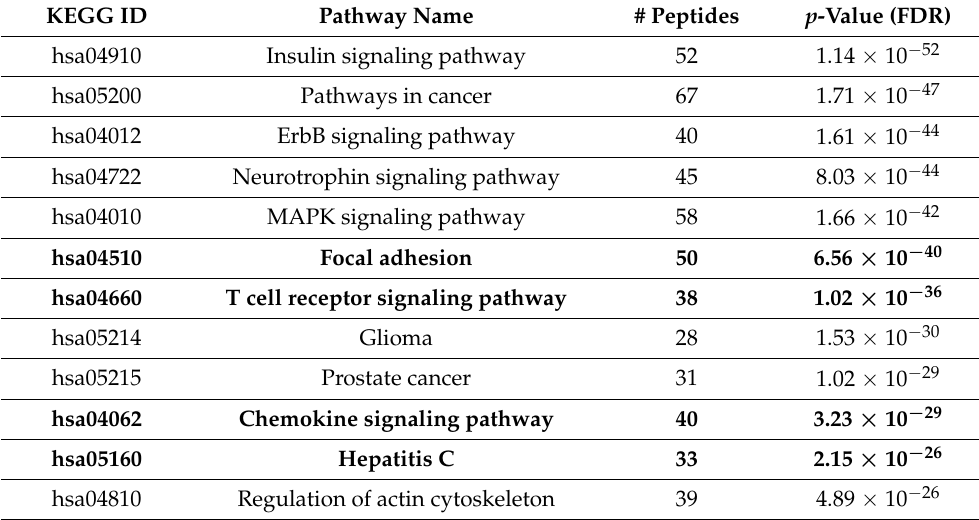
GO analysis where the top three pathways were related to immune function and when combined represent 652 peptides on the array. Table 11. The top 12 KEGG pathways in sub-iliac lymph nodes collected from experimentally and naturally infected cattle. A list of representative pathways is generated using the statistically significant peptides from the comparison and inputting this peptide list into the online STRING database. Presented below are the top 12 pathways. Pathways in bold are those involved in the immune response (total immune peptides: 161).